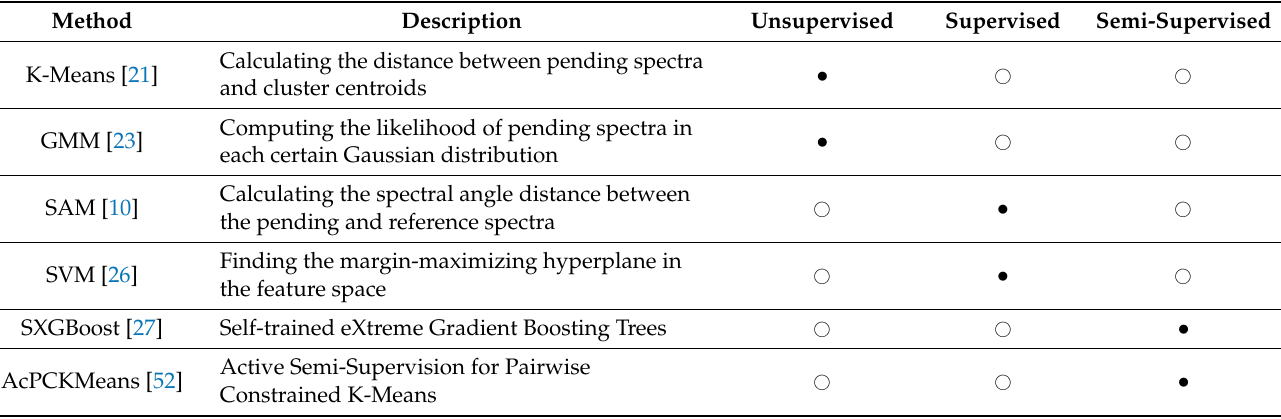
Table 2. The classification methods for the comparison